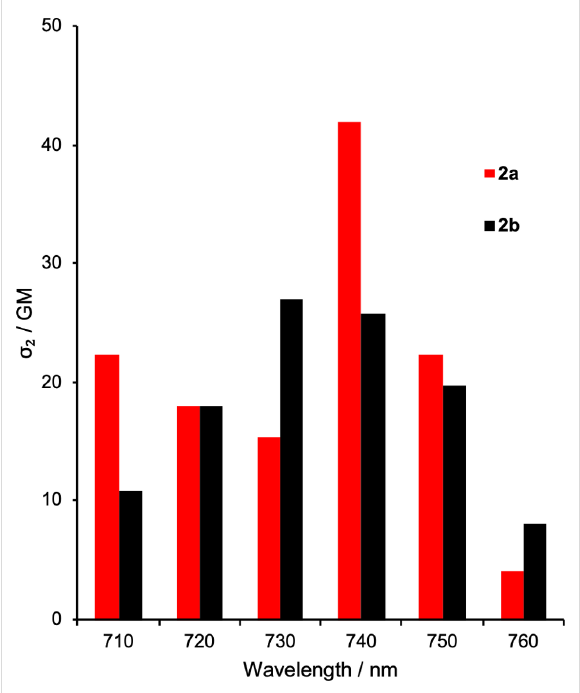
Figure 4: ESR spectra acquired during the photolysis of 2a (5 mM) in benzene using 365 nm light.